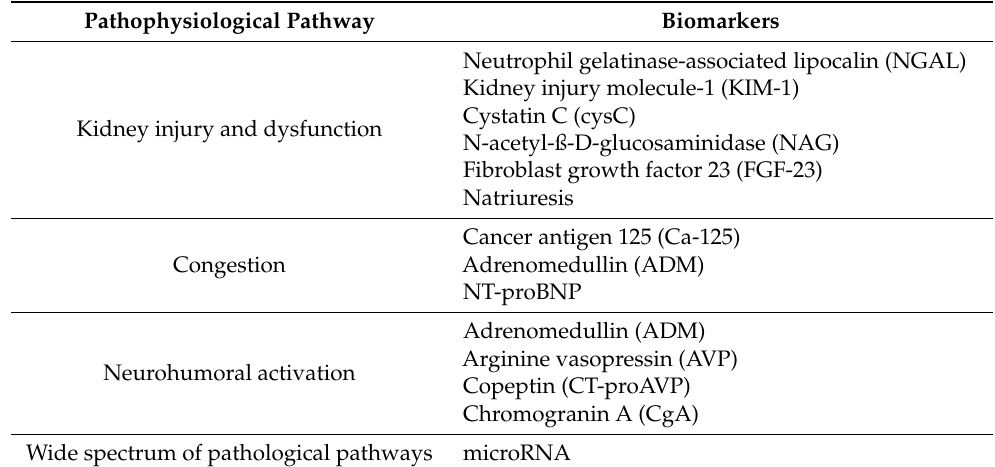
Table 1. Classification of selected biomarkers based on pathophysiological pathways of heart